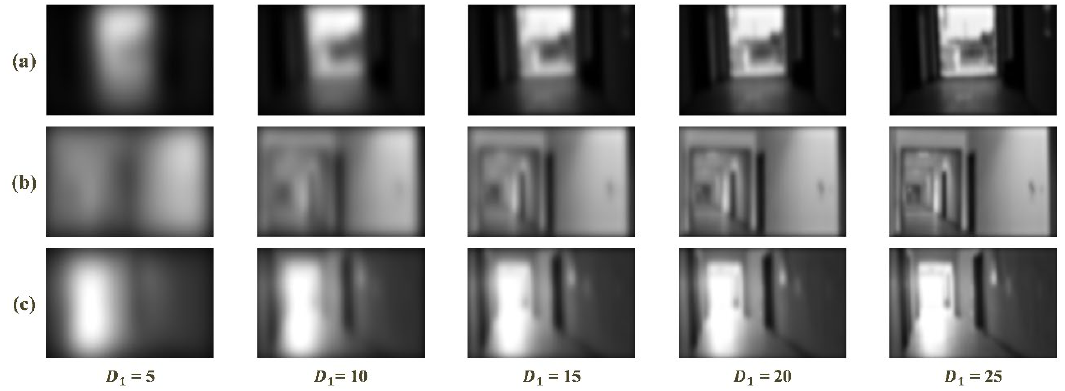
Figure 11. Visual results of low-pass filter with a sequence of D 1 : ( a ) weak illumination; ( b ) normal illumination; and ( c ) bright illumination.